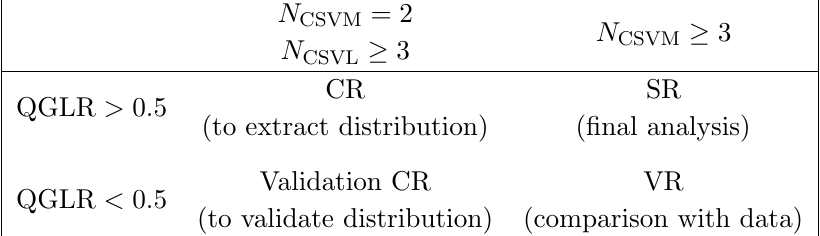
Table 1 . De(cid:12)nition and description of the four orthogonal regions in the